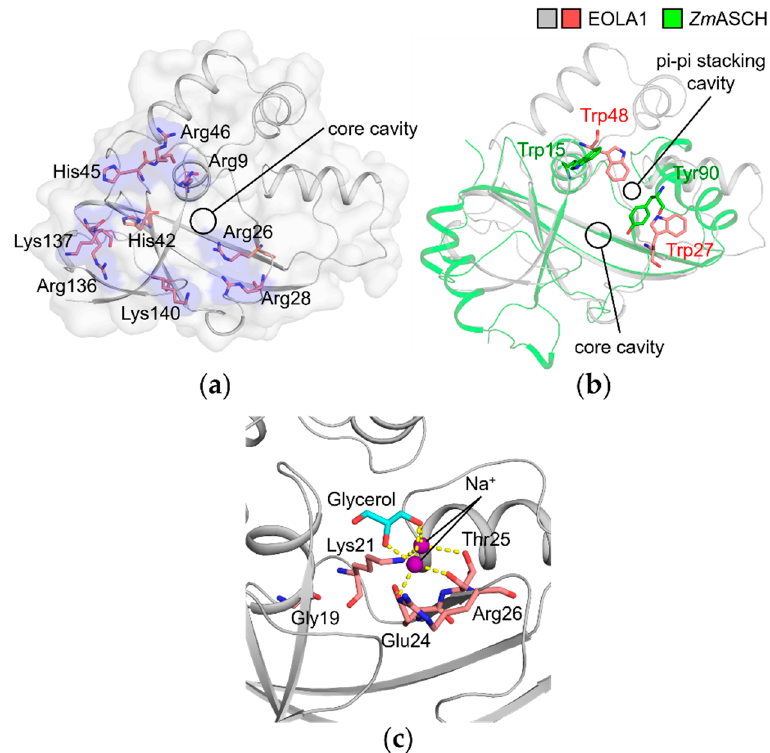
Figure 5. Structural implications of binding between EOLA1 and RNA molecules. ( a ) The basic residues surrounding the core cavity of EOLA1. The residues are shown as salmon sticks and their exposing surfaces are colored in blue. Nitrogen and oxygen atoms are colored in blue and red, respectively. ( b ) The probable pi-pi stacking crevices of EOLA1 and Zm ASCH. Superimposed structures of EOLA1 and Zm ASCH are shown in gray and green cartoons, respectively. Trp27 and Trp48 of EOLA1 are shown as salmon sticks, and Trp15 and Tyr90 of Zm ASCH are shown as green sticks. Nitrogen and oxygen atoms are colored as in ( a ). ( c ) Ligands at the core cavity of EOLA1 in the crystal structure. Gly19, Lys21, Glue24, Thr25, and Arg26 in the ‘ G x K xx E x R ’ motif of EOLA1 are represented as salmon sticks with gray cartoon representation of EOLA1. The glycerol and two sodium ions are colored in cyan and purple, respectively. Nitrogen and oxygen atoms are colored as in ( a ).